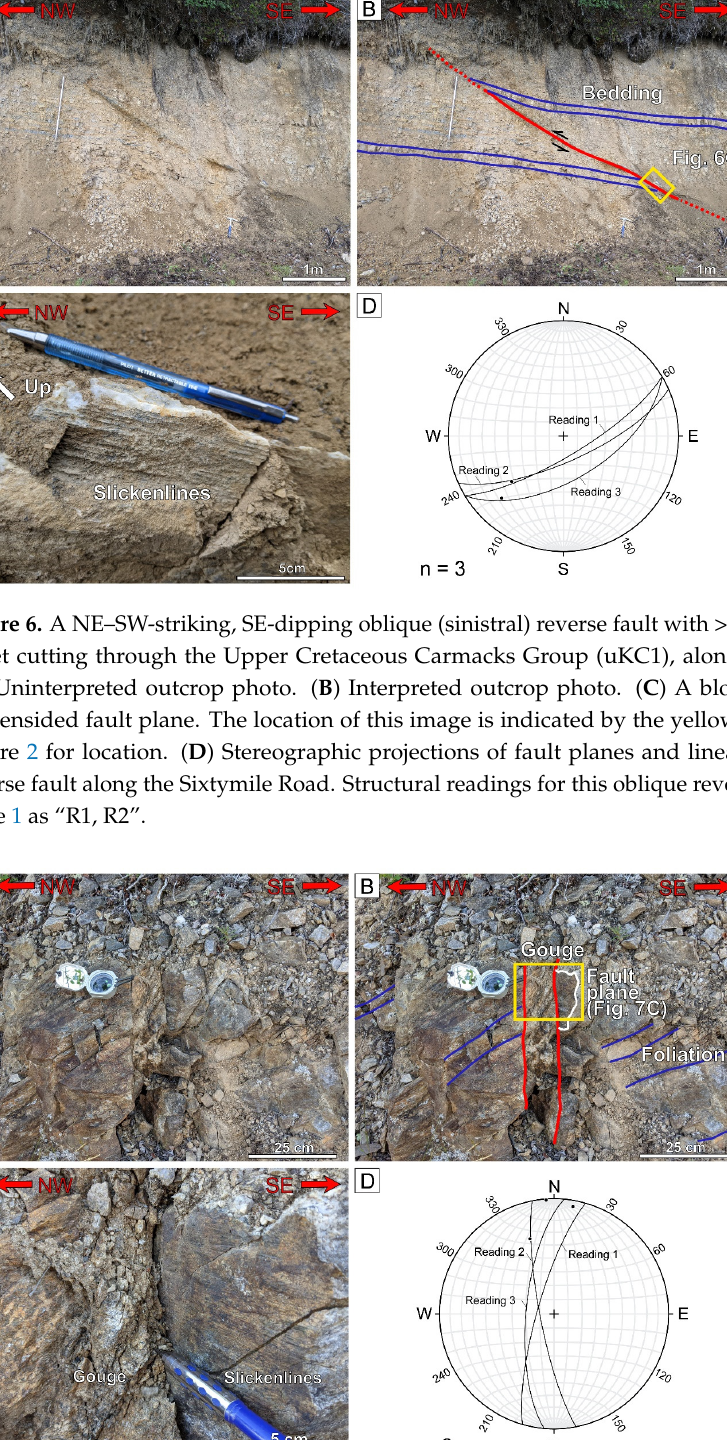
Figure 7. Close-up view of the gouge and slickenlines on the nearly N–S-striking strike-slip fault south of the Sixtymile river shown in Figure 8. ( A ) Uninterpreted outcrop photo. ( B ) Interpreted outcrop photo. ( C ) A blown-up image showing the slickensided fault plane and fault gouge. The location of this image is indicated by the yellow box in ( B ). Refer to Figure 2 for location. ( D ) Stere- ographic projections of fault planes and lineations of the strike-slip fault in the Sixtymile River area. Structural readings for this strike-slip fault are listed in Table 1 as “SS1, SS2”.